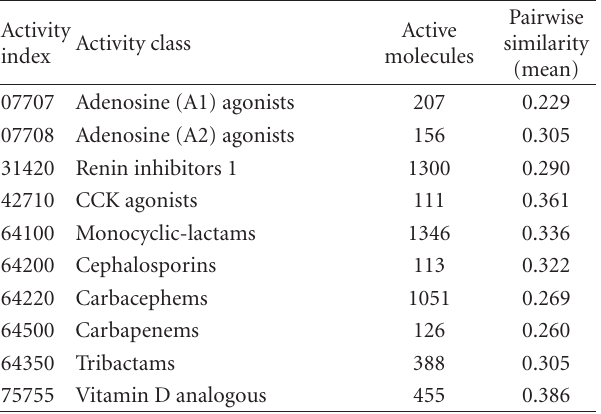
Table 2: MDDR activity classes for DS2 dataset.